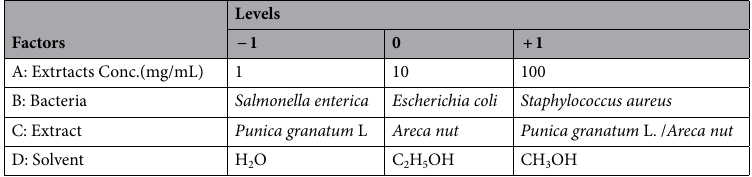
Table 1. The factors and levels of the input variables.